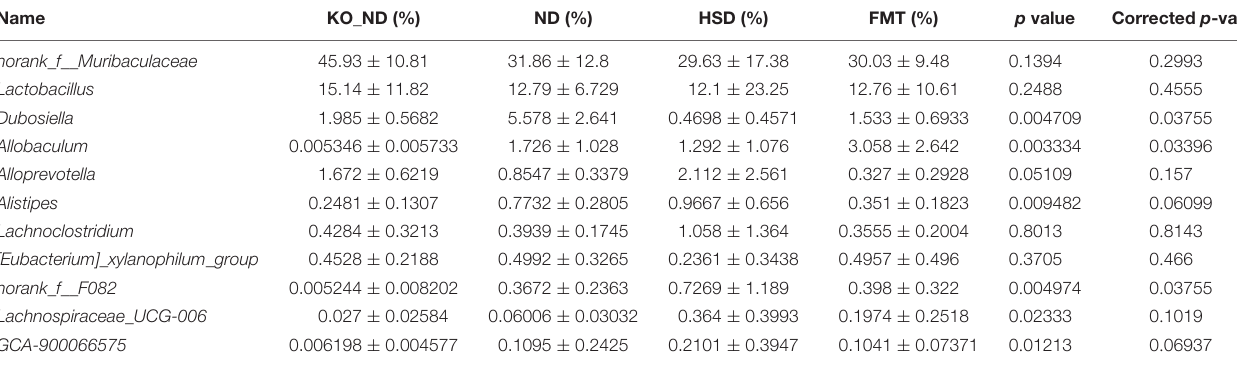
TABLE 1 | Relative abundance of fecal microbiota transplantation-related taxonomic groups (Mean ± SD; n =